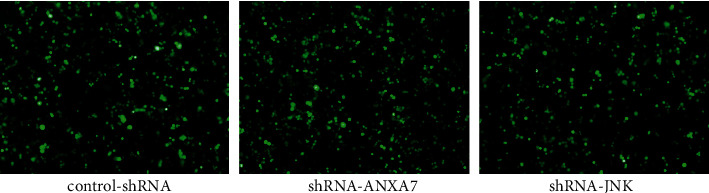
Transfection efficiency of control-shRNA, shRNA-ANXA7, and shRNA-JNK Hca-P cell groups as verified by green fluorescence protein emission from the pGPU6/GFP/Neo shRNA vector at 48 h (magnification, 100x).